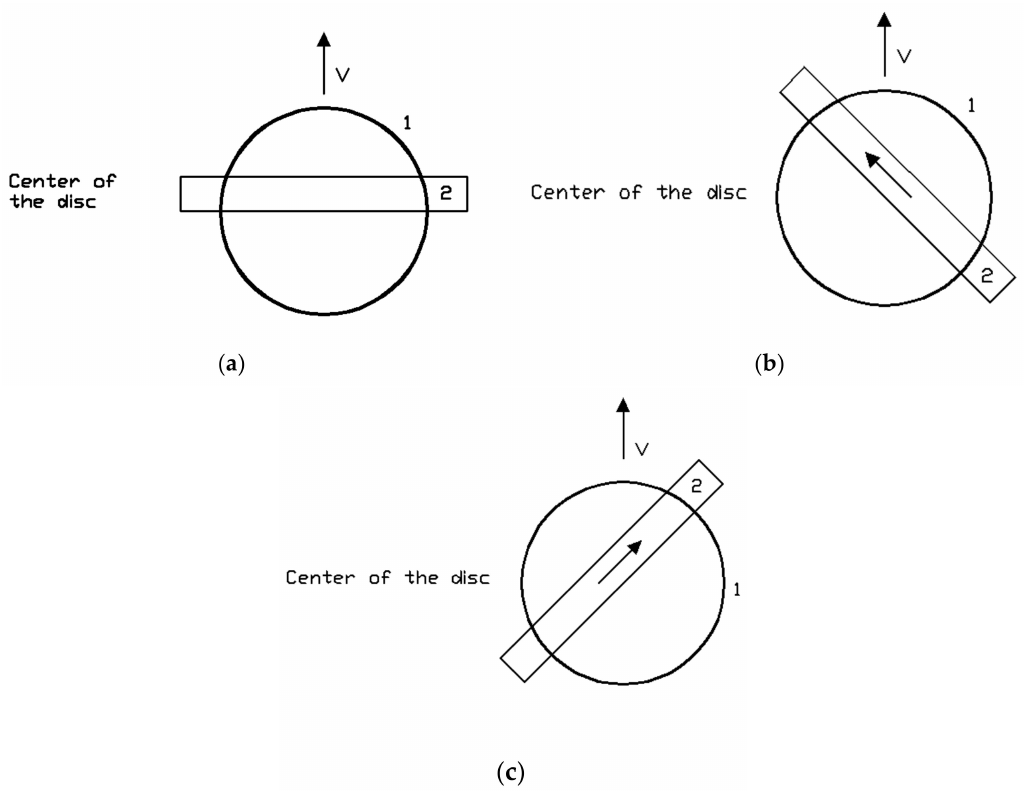
Figure 14. Scheme of oil flow inside the groove depending on the contact between the spiral fragment and the counter-sample; V- linear speed, 1–the contact area with the counter-sample, 2–the position of the spiral groove; ( a ) equal flows of the lubricant, ( b ) the flow directed to the center of the disc, and ( c ) flow outside the